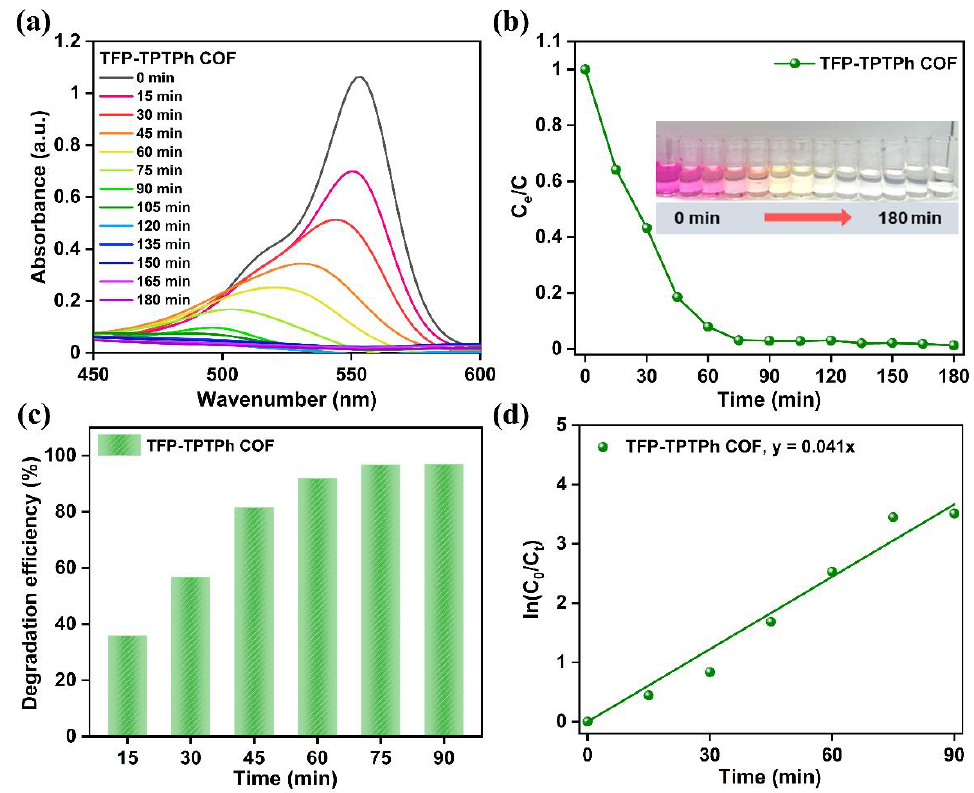
Figure 5. ( a ) UV–Vis spectra for the photodegradation of an aqueous RhB solution (56 mL, 10 mg L − 1 ) at various time intervals (from 0 to 180 min) after the addition of TFP-TPTPh COF (7 mg), all measurements were carried out at 25 °C, stirring speed = 600 rpm, pH = 7. ( b ) Photocatalytic efficacy of TFP-TPTPh COF (7 mg) for the degradation of photodegradation of an aqueous RhB solution (56 mL, 10 mg L ‒1 ) under ultraviolet and visible light irradiation, all measurements were carried out at 25 °C, stirring speed = 600 rpm, pH = 7. ( c ) Pseudo-first-order kinetic curve for the degradation of photodegradation of an aqueous RhB solution. ( d ) Photodegradation efficiency for the adsorption of RhB (56 mL, 10 mg L ‒1 ) onto TFP-TPTPh COF (7 mg), all measurements were carried out at 25 °C, stirring speed = 600 rpm, pH = 7.